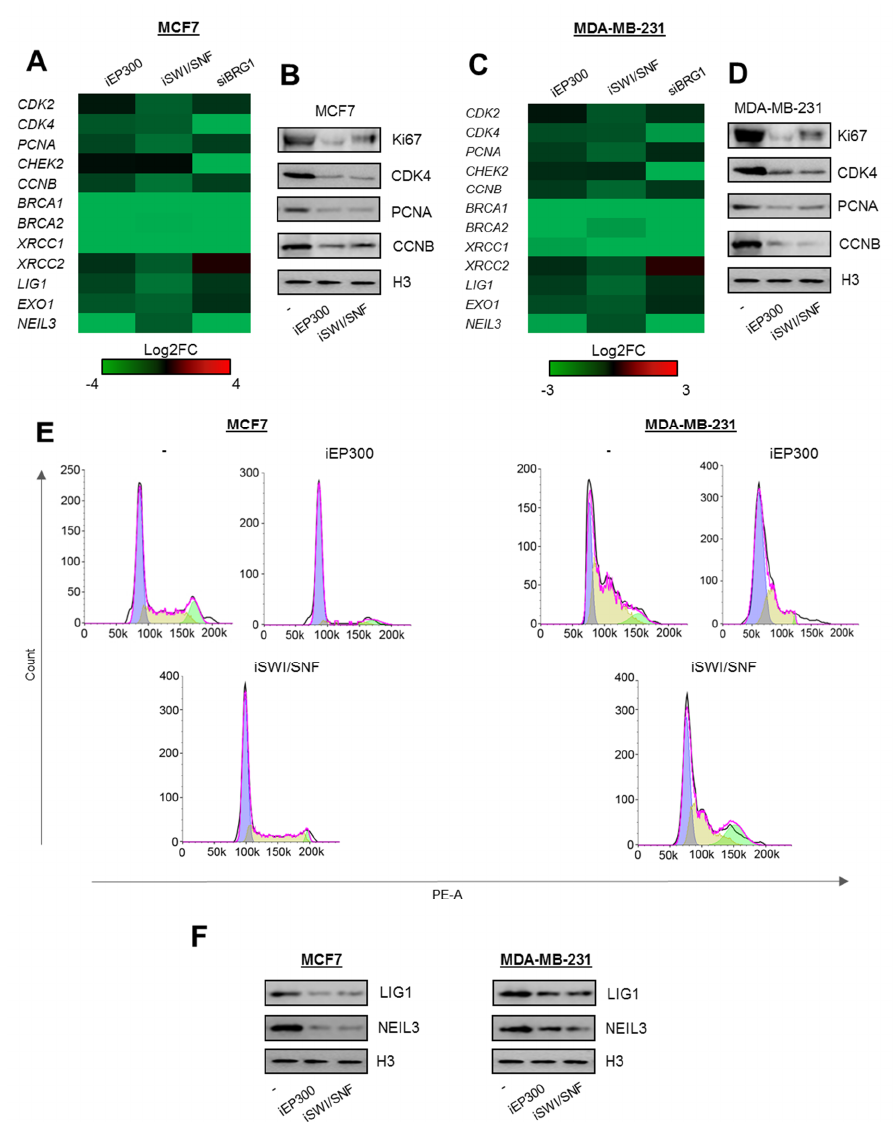
Figure 2. Proliferation and DNA repair-relevant gene promoters are controlled by BRG1 and EP300 activity in breast cancer cells. ( A and C ) Long-term (48 h) deficiency of BRG1 and EP300 activity limits transcription of genes encoding components of cell division and DNA repair mechanisms. The data present Log2FC of mRNA level measured by real-time PCR normalized to untreated control (iEP300 and iSWI/SNF) and non-template control (siBRG1). ( B and D ) Gene repression results in substantial loss of proliferation markers as seen from western blot, and by cell growth arrest in G1 phase ( E ). ( F ) Inhibition of BRG1 and EP300 similarly decreases the amount of proteins involved in removal of DNA damage. Heatmaps with long-term BRG1 and Ep300 deficiency ( A and C ) were prepared from four independent replicates for iEp300, and iSWI/SNF; from 3 for siBRG1. Detailed statistical analysis is presented in supplementary Table S3. Western blots in B, D, and F show representative images from three independent experiments. Pictures show cropped areas of western blots. Whole images are included in Figure S3. Analysis of the cell cycle was carried out twice in two technical replicates for each